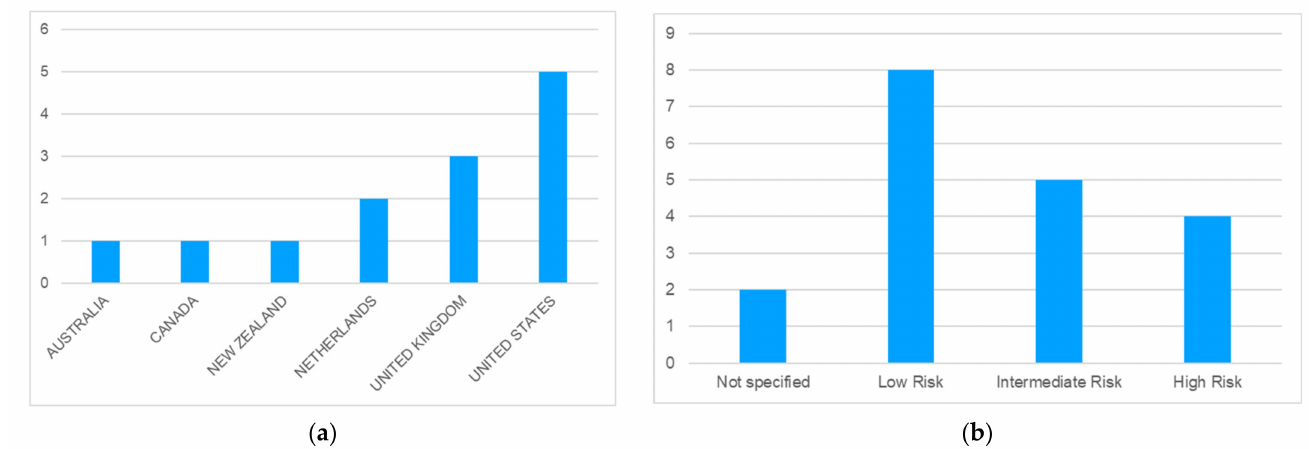
Figure 2. ( a ) Distribution of the articles according to the country analyzed (N = 13). ( b ) Distribution of the articles according to disease-associated